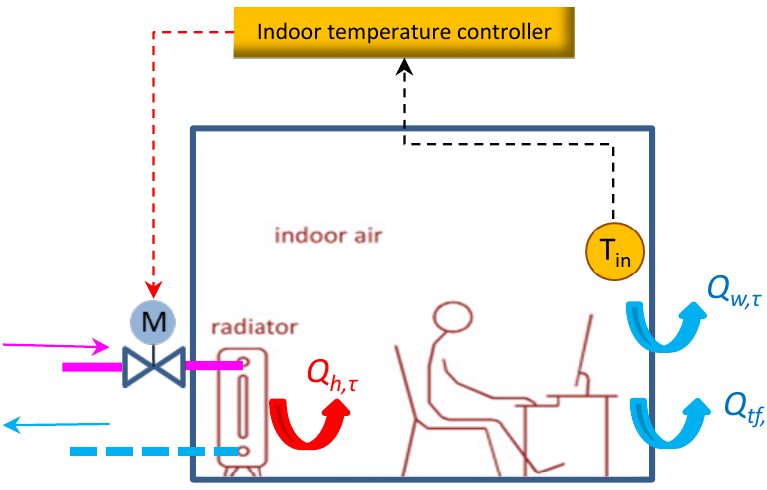
Figure 5. Thermodynamic schematic of a heating room.